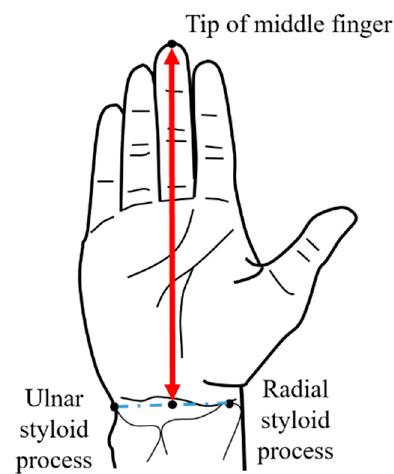
Figure 3. Definitions of the hand length (L01) based on the AIST Japanese hand dimensions database [20].